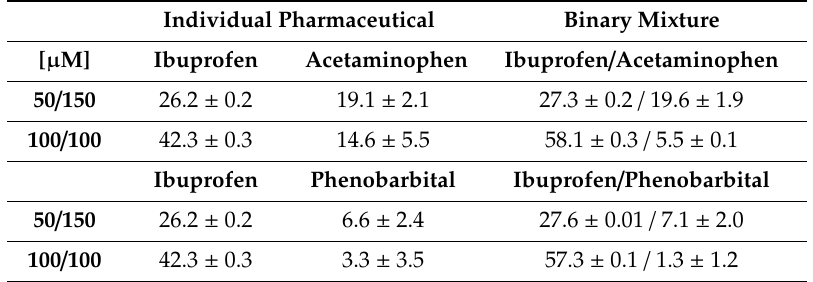
Table 3. Adsorption capacity q t (mg g − 1 ), of TpBD-(CF 3 ) 2 ( C 0 = 330 mg L − 1 ) in binary mixtures of